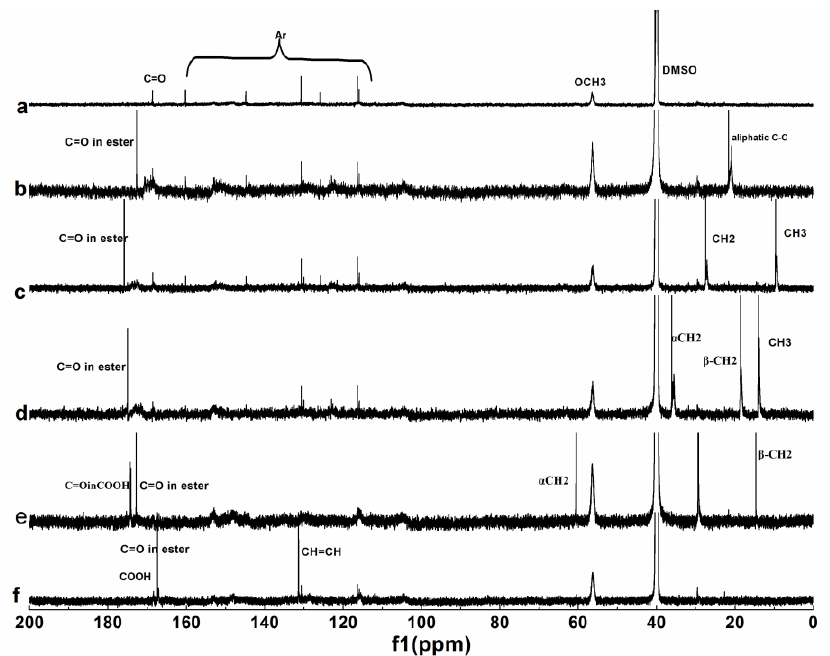
Figure 5. 13 C NMR spectra of lignin and its esters: ( a ) original lignin; ( b ) acetylated lignin (1.5 h); ( c ) propionylated lignin (1.5 h); ( d ) butyrated lignin (2 h); ( e ) succinylated lignin (2 h); ( f ) maleylated lignin (2 h).